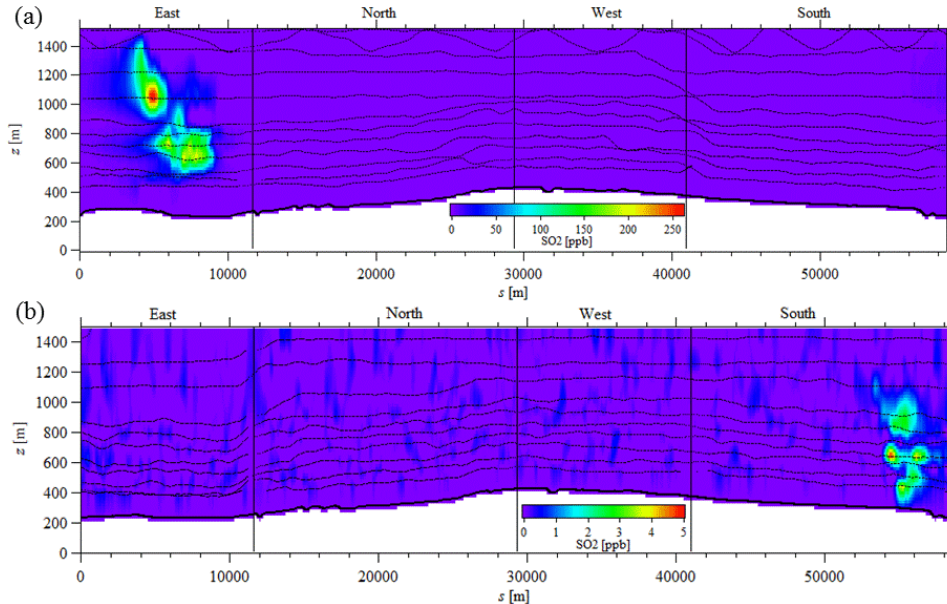
Figure 4. Kriging-interpolated SO 2 mixing ratios for the 20 August (a) and 2 September (b) flights. Note that the colour scales are different. The flight path is superimposed (black dots). The near-surface values are estimated using a zero-constant extrapolation which varies linearly from the lowest measurement to a zero value at the surface.